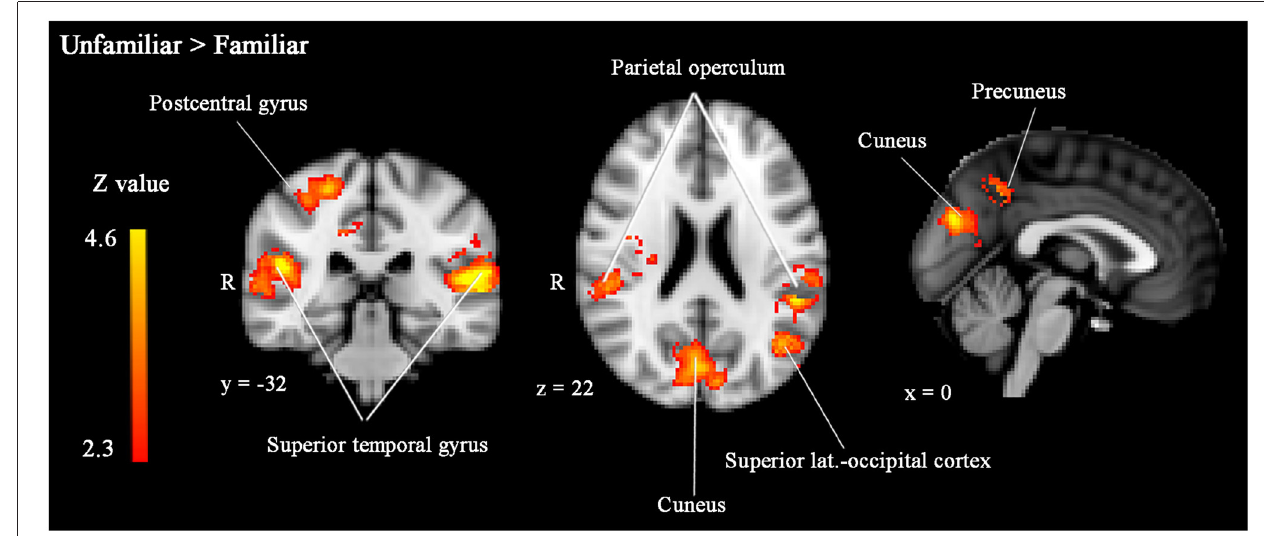
FIGURE 4 | Significantly enhanced activity in bilateral STG, right postcentral gyrus, bilateral parietal operculum, left superior lateral occipital cortex, bilateral cuneus and left precuneus in response to unfamiliar compared to familiar faces. Whole-brain analyses, p < 0.05, corrected by cluster threshold ( Z >